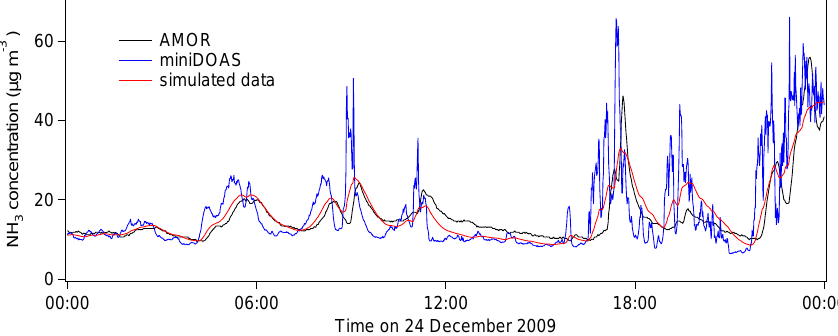
Fig. 21. Minute values of the miniDOAS, and the AMOR compared to delayed and smoothed miniDOAS data. Both the miniDOAS data and the delayed and smoothed miniDOAS data have been augmented with an offset of 3.4 µg m − 3 .